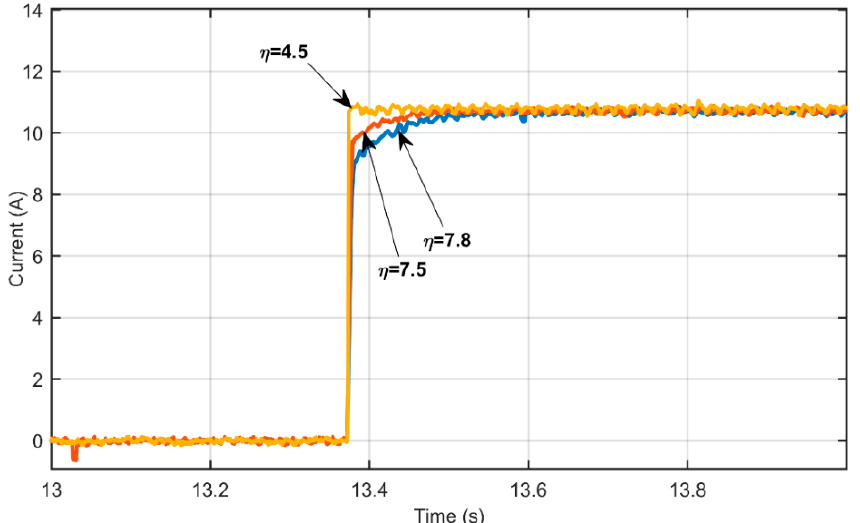
Figure 9. Transient response of the resistive load current with the control input MPC-DOB ( (cid:1873)((cid:1863)) ) and the steady-state control input (cid:1873) (cid:3042) ((cid:1863)) for η = 7.8.